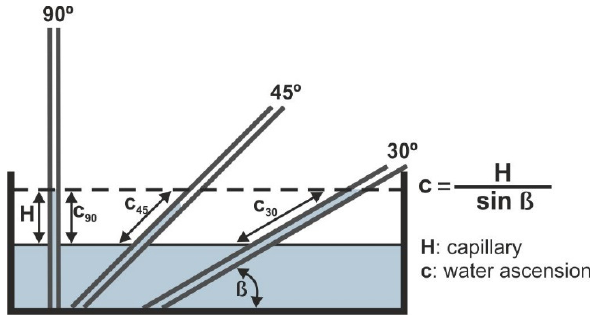
Figure 4. Capillary ascension depending on surface angle, and the trigonometric conversion used in this study.